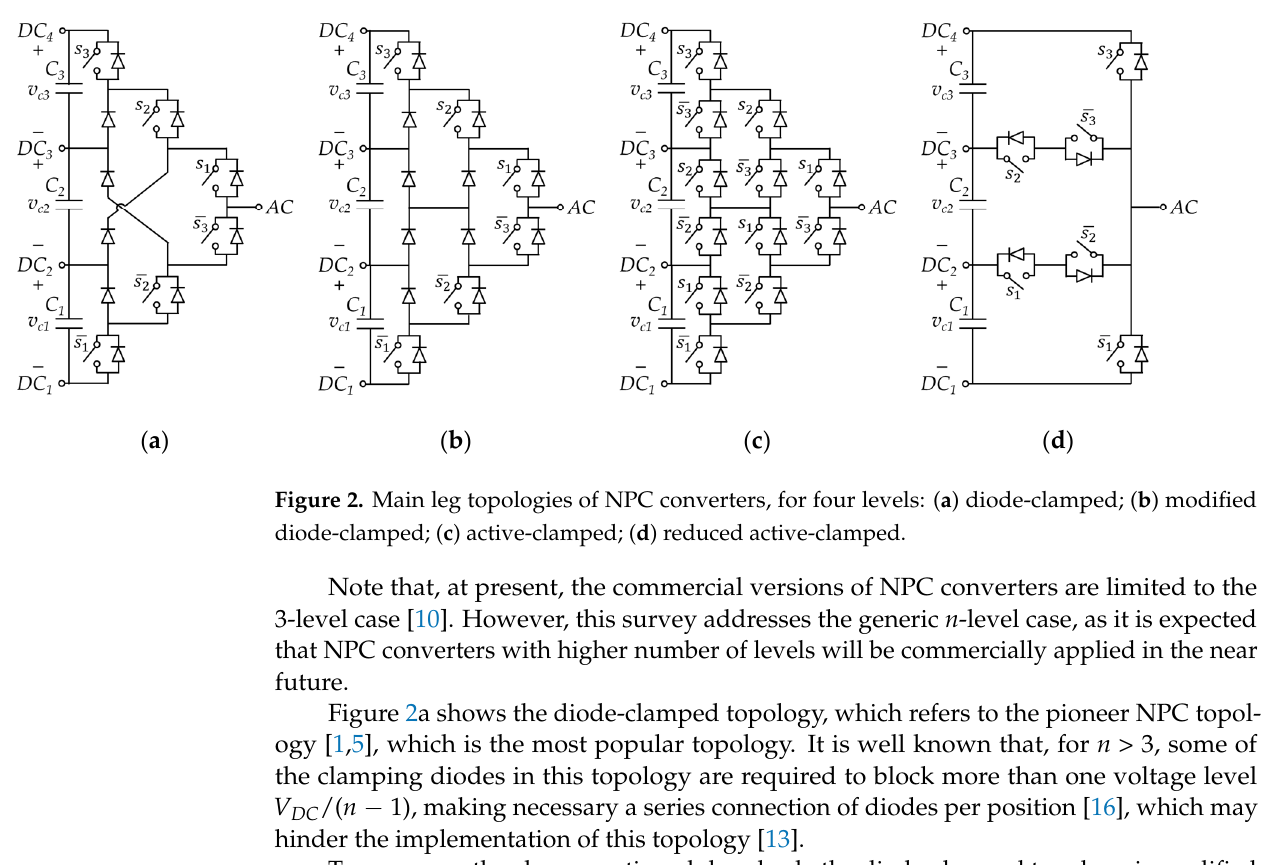
Figure 3. Basic classification of modulations for multilevel converters. 2.3.1. Space Vector Control At every point in time, the space vector closest to the reference vector is selected and applied in the converter [59]. Figure 4a shows the space vector diagram for a 5-level three-phase converter, where the steady-state circular reference vector trajectory is de- picted in dashed red. The different space vectors selected for this specific reference vector trajectory are highlighted in red. The output voltage generated with this modulation is not able to follow the fundamental reference voltage, presenting steady-state error and low-order harmonics. It is mainly intended for converters with a very high number of levels. This strategy can also be implemented on a per leg basis through selecting the leg AC terminal voltage closest to the reference voltage, as shown in Figure 4b. In this case, the strategy receives the name of nearest-level control [16].